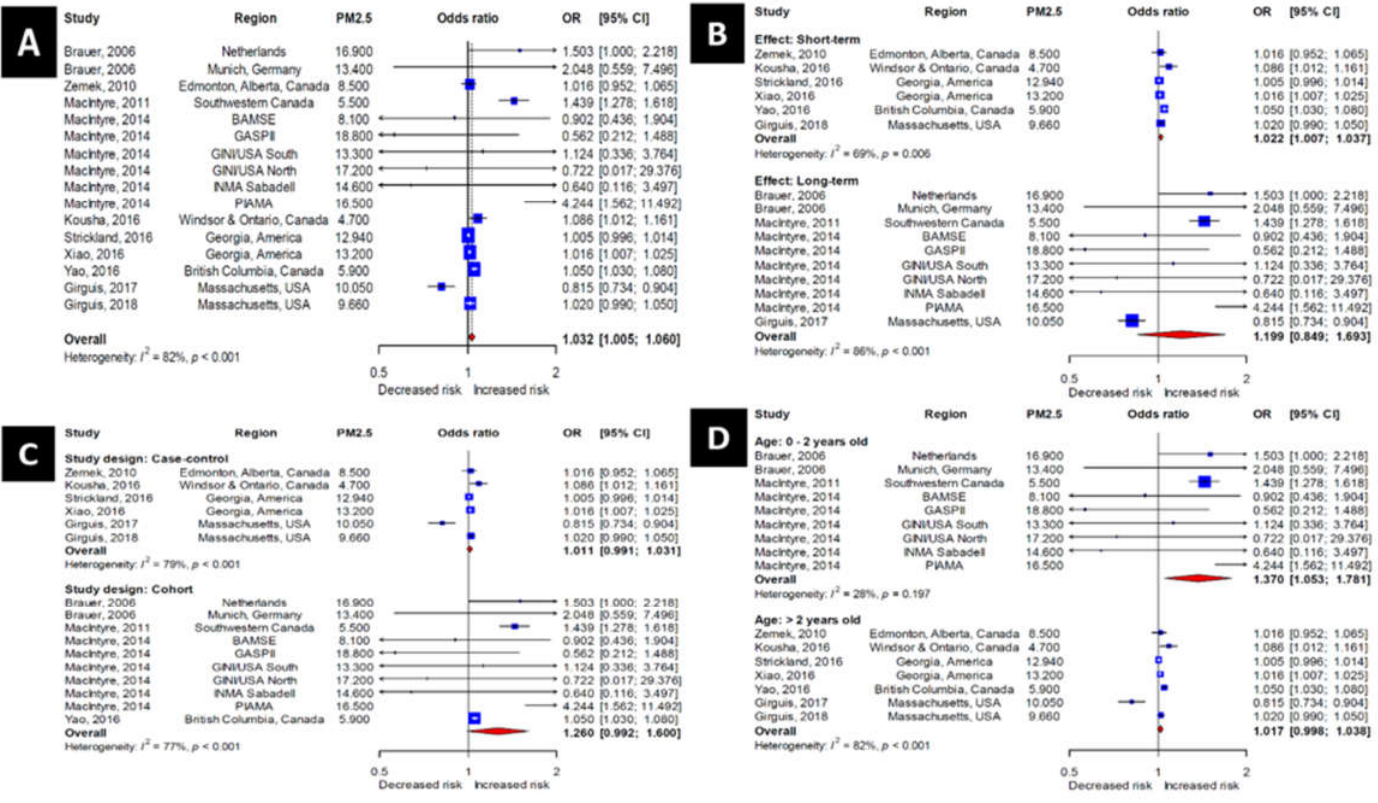
Figure 2. Forest plots for the PM 2.5 group. (A)—All subjects. (B)—Short- and long-term effect models. (C)—Case–control and cohort studies. (D)—Younger and older children.